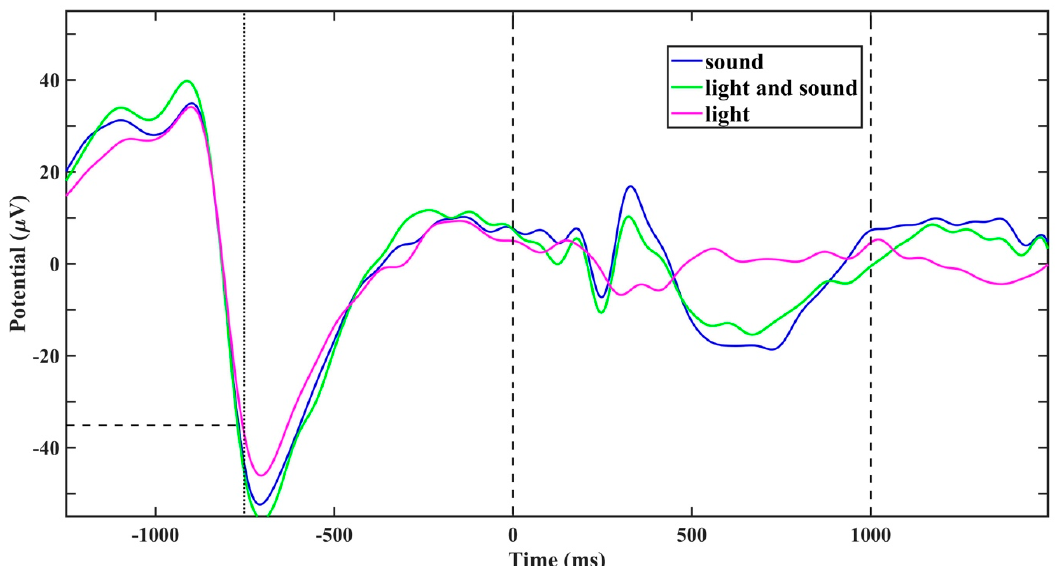
Figure 4. Average EEG waveforms, referenced to the time of the first (of two paired) stimuli presentation (vertical dashed line at 0 ms), time-locked to the detection of EEG-wave threshold ( − 35 µ V for this representative subject #9; vertical line at − 750 ms). The sound and light and sound stimuli evoked distinct event-related potential (ERP) that included all the classic ERP components (P200, N350, P450, N550, and P900 [11,21]).